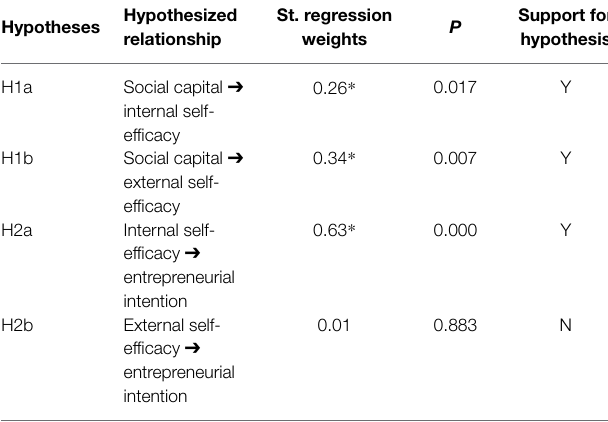
TABLE 3 | Testing of hypotheses. Hypothesized Hypotheses